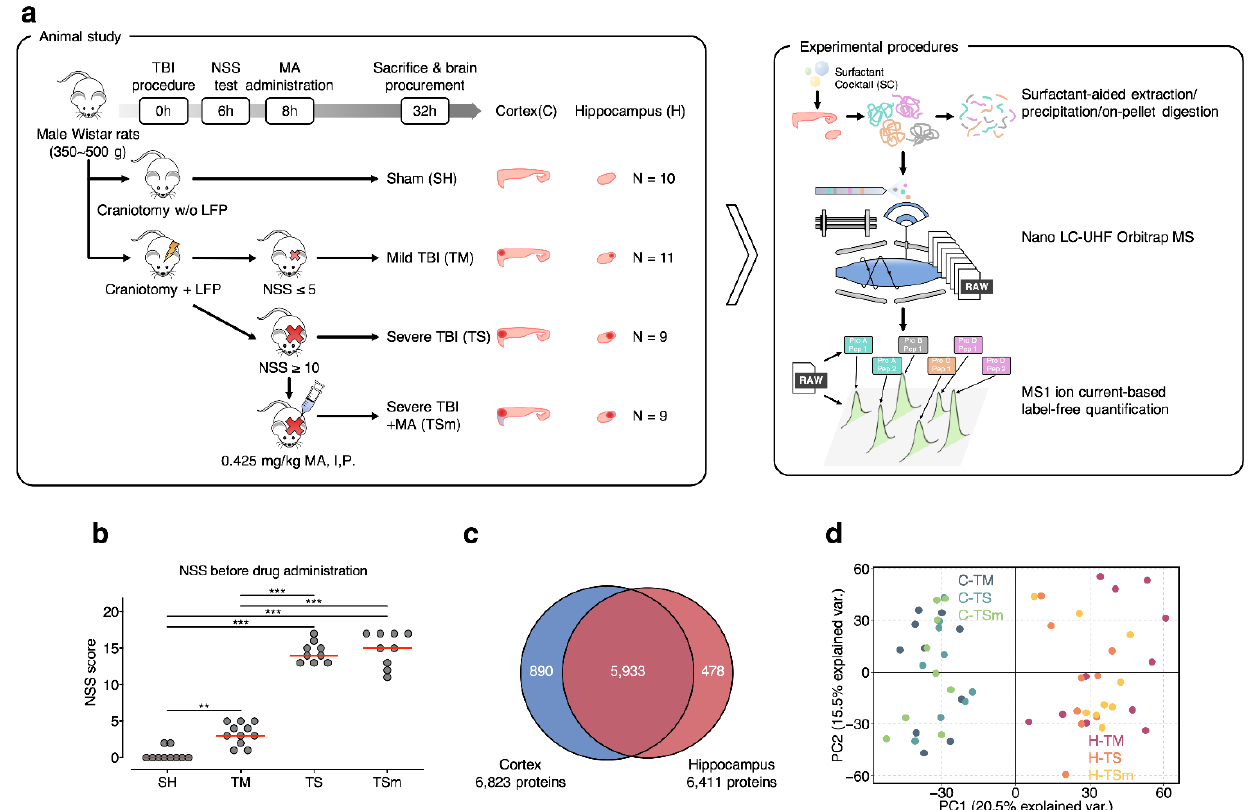
Figure 1. Quantitative proteomics profiling of cortical and hippocampal tissues procured from a rat lateral fluid percussion injury (FPI) model of traumatic brain injury (TBI). ( a ) The scheme of animal study and proteomic experimental procedures; ( b ) Neurological Severity Score (NSS) test results of animals involved in the study. Double asterisks (**) and triple asterisks (***) denote p < 0.01 and p < 0.001 determined by one-way ANOVA + Tukey honestly significant difference (HSD) test; ( c ) Venn diagram of proteins quantified in cortex and hippocampus samples; ( d ) principal component analysis (PCA) of 5933 proteins quantified in both the cortex and hippocampus.